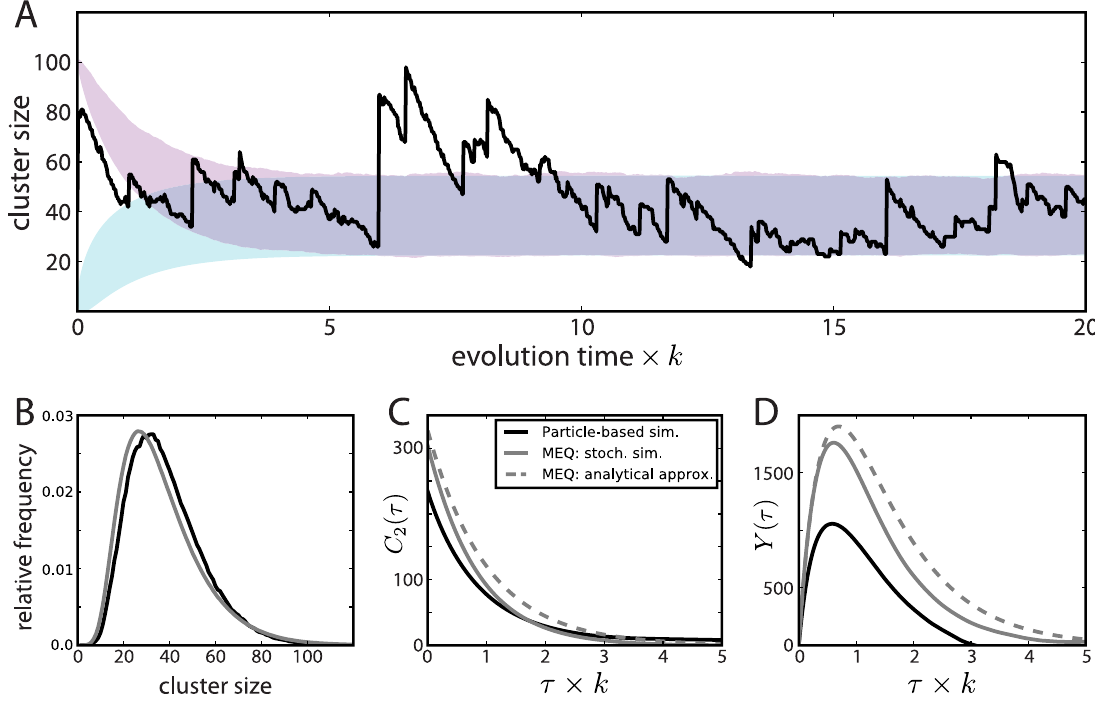
Fig 4. Predicted size evolution of individual clusters. A: Average cluster size (mean ± SD) evolutionfor clusters of an initial size of 2 (light blue) and 100 (light red) particles, respectively,averaged over independentsimulatedcluster size trajectories ( n 2 = 50 (cid:1) 10 6 , n 100 = 4000) sampledfrom simulations. A typical cluster size trajectory is also shown (dark solid line). Simulation parameters are identicalto Fig 2A. B: The distributionof cluster sizes at long times. Large clusters persist for a long time and explore the size distributionshown here due to particleadditionby fusion with other clusters and particle removalby desorption. The distributionobtained from simulatedtrajectories( n = 1000) using the master equation(MEQ) approach(grey solid line, see text for details)is slightly different as spatialcorrelationsare ignored.C: Autocorrelation, C 2 ( τ ) = h n ( t + τ ) n ( t ) i − h n i 2 , of the cluster size n ( t ) obtainedfrom full particle simulations (black solid line) and from the MEQ approach(solid grey line). The analyticalprediction of an exponential decay with characteristic rate k is also shown (dashedgrey line). D: The function Y ( τ ) = h n ( t + τ ) n ( t ) 2 i − h n ( t + τ ) 2 n ( t ) i is shown (solid black line). The fact that Y ( τ ) is non-zeroimpliesthat the dynamics is not invariantunder time reversaland therefore out-of-thermodynamic-equilibrium.The approximation Y ( τ ) / exp( − k τ )[1 − exp( − k τ )] is also shown (dashedgrey line) as well as the function Y ( τ ) generatedby the MEQ approach(solid grey line) (see text and S1 Text: Rate Equations for